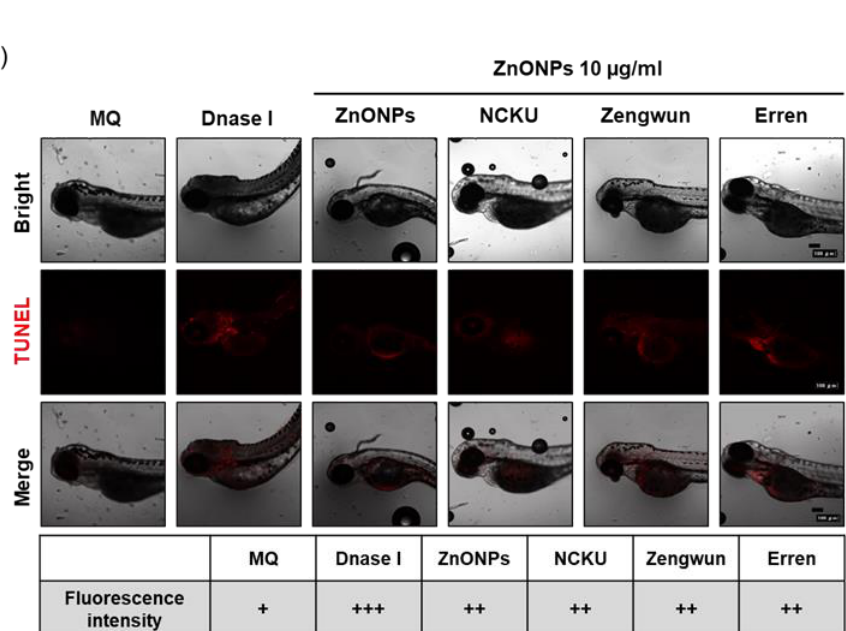
Figure 6. Cytotoxicity of AgNPs and ZnONPs. Zebrafish embryos were exposed to natural water after passing through a 0.45 µm filter and then spiked with NPs. After 72 hpf, zebrafish embryos were subjected to a TUNEL assay. Fluorescence images and intensity of ( a ) AgNPs and ( b ) ZnONPs. Apoptotic cells are represented by red fluorescence signals. The fluorescence intensity was assigned as + (weak), ++ (middle), and +++ (strong). Both AgNPs and ZnONPs spiked in natural water produced increased apoptosis signals in the 10 µg/mL NP groups. AgNPs, silver nanoparticles; ZnONPs, zinc oxide nanoparticles; hpf, hours post-fertilization.